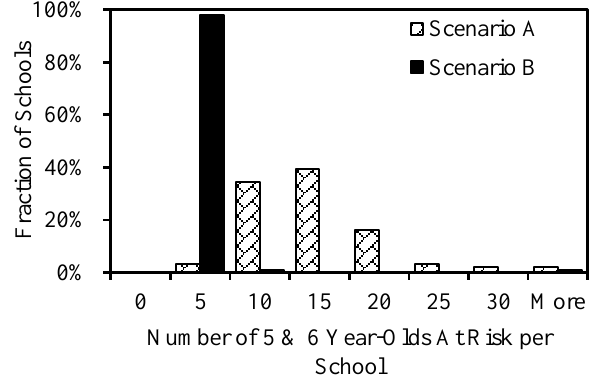
Figure 3. Distribution of at-risk population for elementary schools.